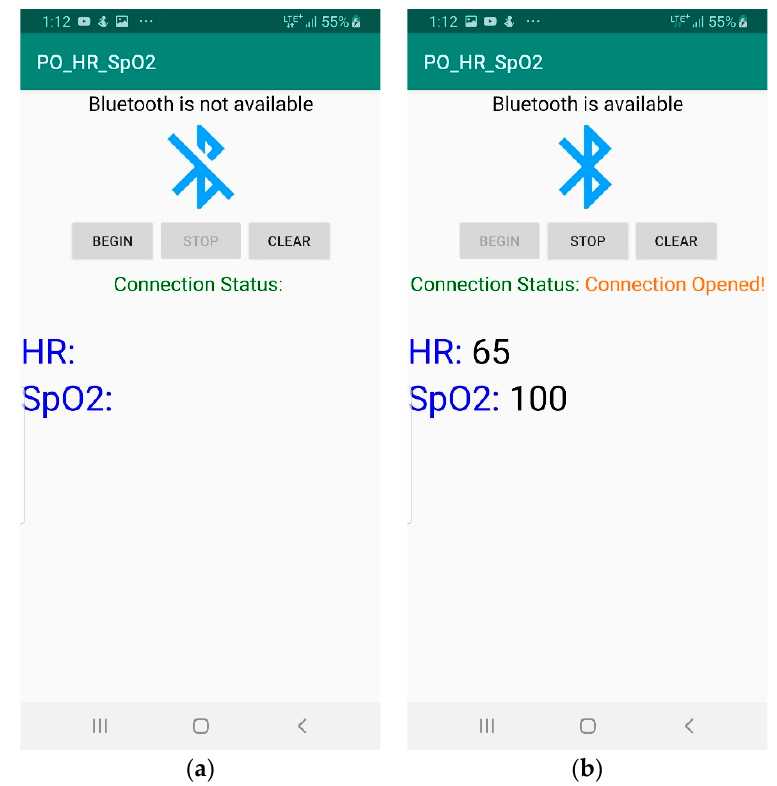
Figure 18. Implementation of the wearable version of the PO system. PCB, printed circuit board. ( a ) Serial Converter ( b ) PCB.